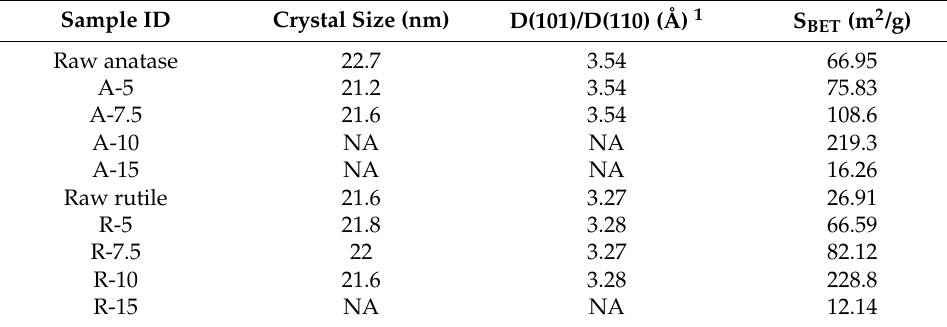
Figure 4. XRD patterns of the synthesized catalysts originating from anatase ( a ) and rutile ( b ) TiO 2 with different concentrations of NaOH in hydrothermal process. Table 1. Characteristics of synthesized titania catalysts.